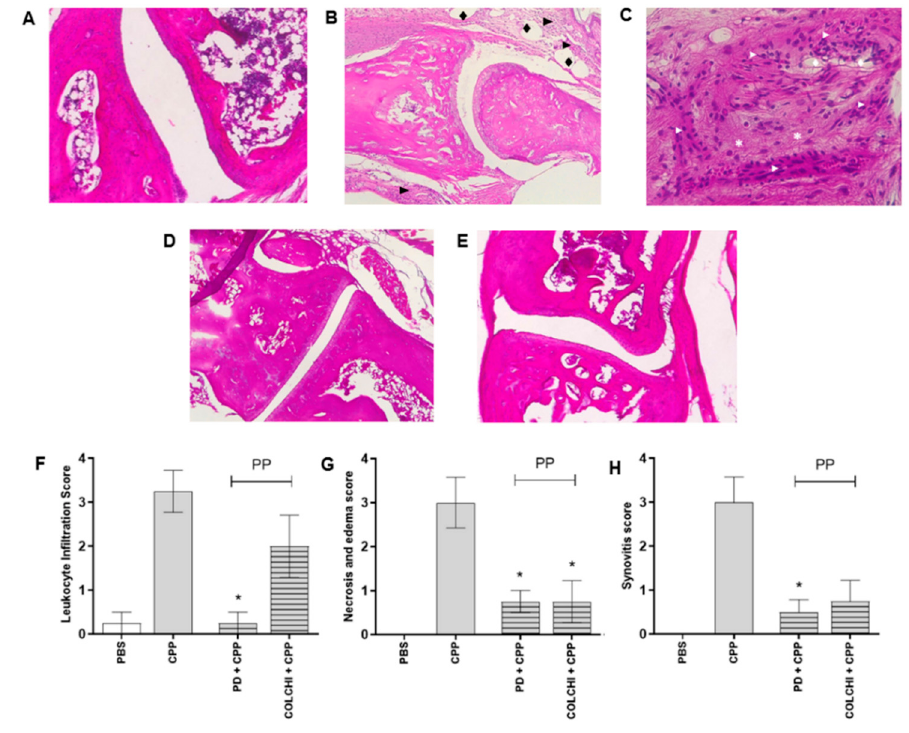
Figure 3. Leukocyte infiltration, necrosis and edema, and synovitis scores calculated on hematoxylin and eosin (H&E) stained sections of the ankles 48 h after CPP crystal injection. Mice were treated by gavage with PD (40 mg/kg) or colchicine (1 mg/kg) before and after (prophylactic) the injection of the crystals (0.3 mg/20 μ L) (n = 8/group). Histological sections: ( A ) PBS 20 μ L; ( B ) CPP; ( C ) detail of image B with symbols depicting inflammatory infiltrate ( ► ), edema ( ♦ ) and necrosis (*); ( D ) PD + CPP (prophylactic); ( E ), colchicine + CPP (prophylactic). Magnification 10 × . Histological parameters: ( F ) leukocyte infiltration, Kruskal–Wallis test p = 0.0019, * p < 0.05 vs. CPP; ( G ) necrosis and edema, Kruskal–Wallis test p = 0.0016, * p < 0.05 vs. CPP; ( H ), synovitis, Kruskal–Wallis test p = 0.0086, * p < 0.05 vs.